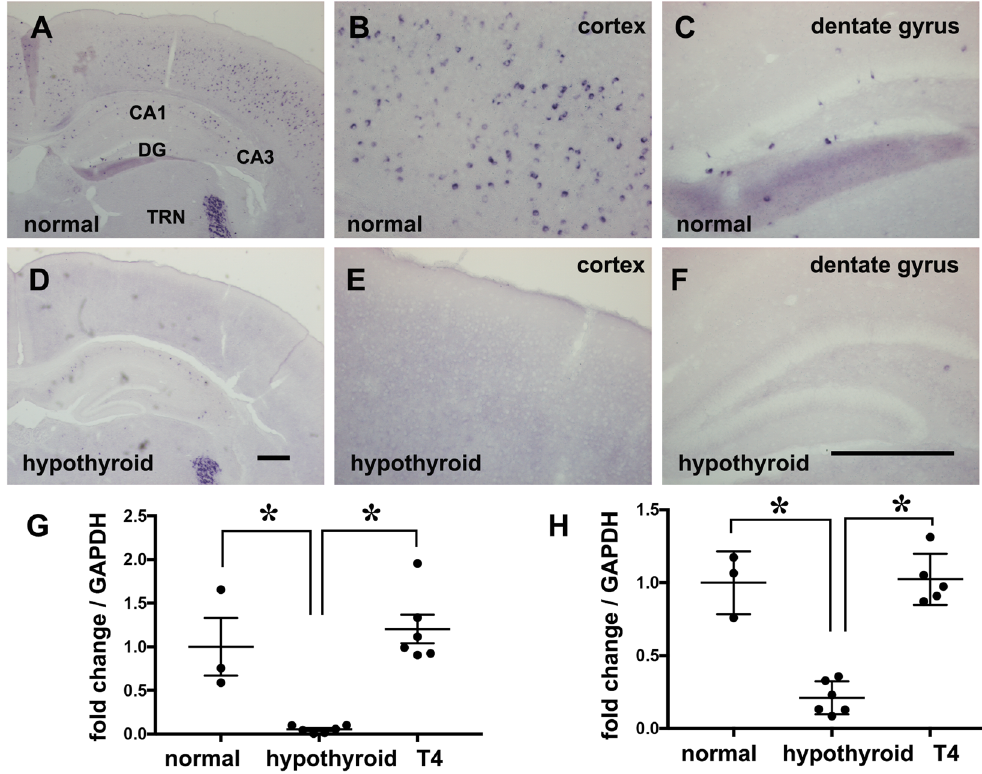
Figure 3. Expression of PV mRNA in the cerebral cortex and hippocampus at PD 14 after termination of treatment with antithyroid agents. ( A – C ) Expression of PV mRNA in the cerebral cortex and hippocampus of normal mice. ( B , C ) Magnified images of the cerebral cortex ( B ) and the dentate gyrus of the hippocampus ( C ) from ( A ). ( D – F ) Expression of PV mRNA in the cerebral cortex and hippocampus of hypothyroid mice. ( E , F ) Magnified images of cerebral cortex ( E ) and the dentate gyrus of the hippocampus ( F ) from ( D ). Scale bar = 400 µm. CA Cornu Ammonis, DG dentate gyrus, TRN thalamic reticular nucleus. ( G , H ) Graphs show expression of PV mRNA in the cortex ( G ) and hippocampus ( H ) using qPCR. *p < 0.01: normal vs. hypothyroid (cortex), p < 0.001: hypothyroid vs. T4 (cortex). *p < 0.001: normal vs. hypothyroid (hippocampus), p < 0.001: hypothyroid vs. T4